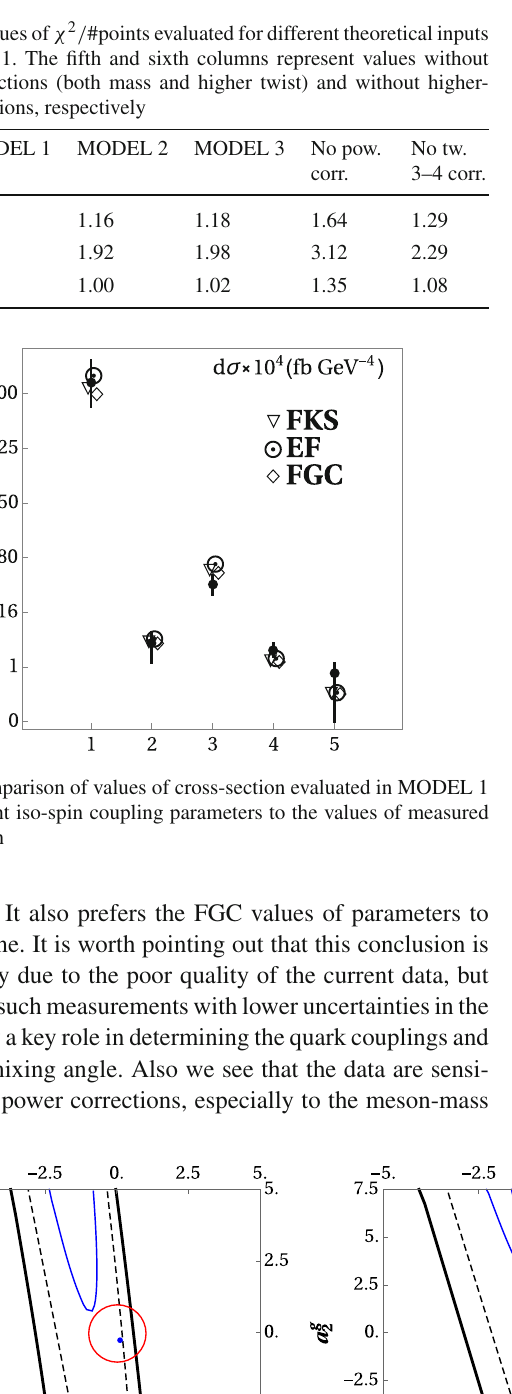
red circle designates the approximate region of the theoretical expecta- tion for DA parameters. In each plot, two relevant moments of the DA are varied, while the third one is taken from MODEL